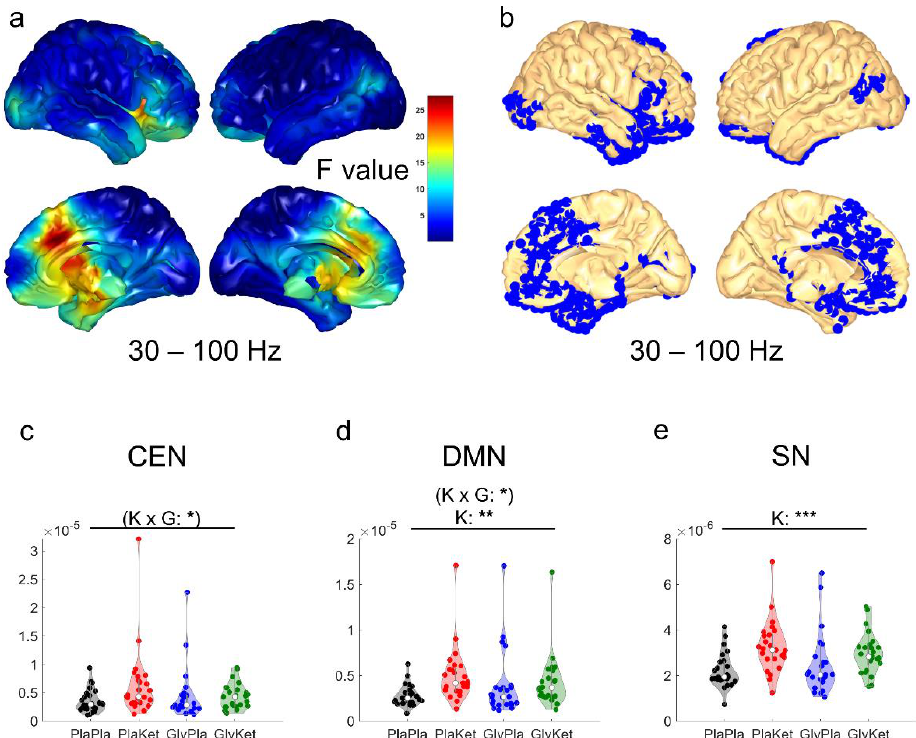
Figure 3. ( a ) Cortical map with F-values obtained by voxel-wise main effect analyses for ketamine of source activity computed as exact low-resolution brain electromagnetic tomography (eLORETA) in the gamma frequency band (30 – 100 Hz). ( b ) Blue voxels depict corresponding significantly increased (pFDR < 0.05) source activity during the administration of ketamine in three large clusters. Violin plots of the mean network source-localized gamma (30 – 100 Hz) power of all regions of interest (ROI) in the central executive network (CEN; c ), the default mode network (DMN; d ), and the salience network (SN; e ) for all four conditions: the PlaPla (black dots), PlaKet (red dots), GlyPla (blue dots), and GlyKet condition (green dots). (K × G: ketamine × glycine interaction term; K: ketamine main effect; * p < 0.05; ** p < 0.01, *** p < 0.001; effects that were no longer significant after FDR correction are shown in parentheses).